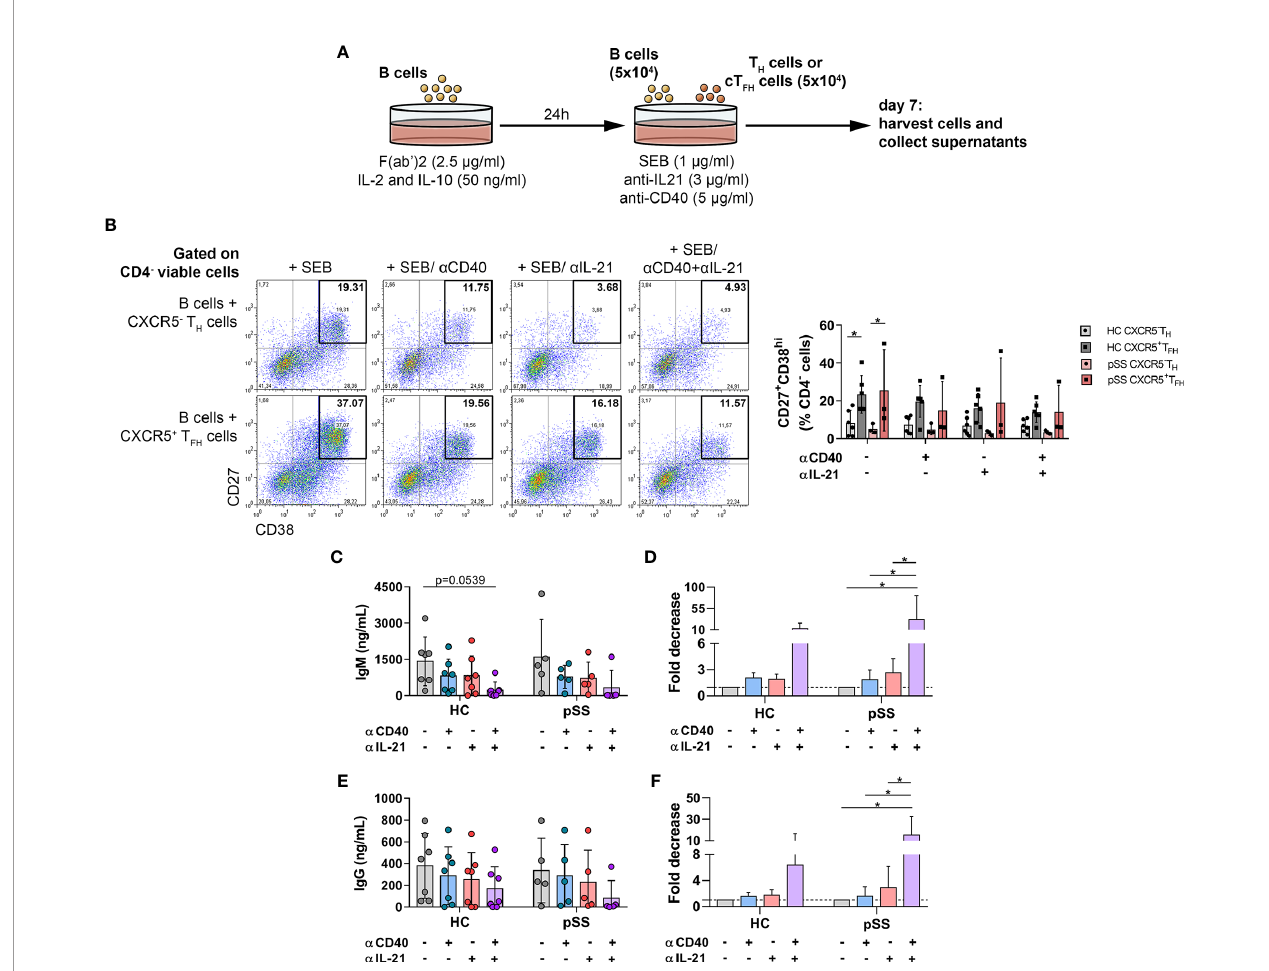
FIGURE 3 | The effects of anti-human CD40/TNFRSF5 and anti-IL-21 on B-cell differentiation and antibody production. (A) Graphical representation of B-T H /cT FH co-culture assay. Magnetically isolated CD19 + B cells were pre-activated with F(ab ′ )2 fragment in the presence of recombinant IL-2 and IL-10 for 24 h. Isolated